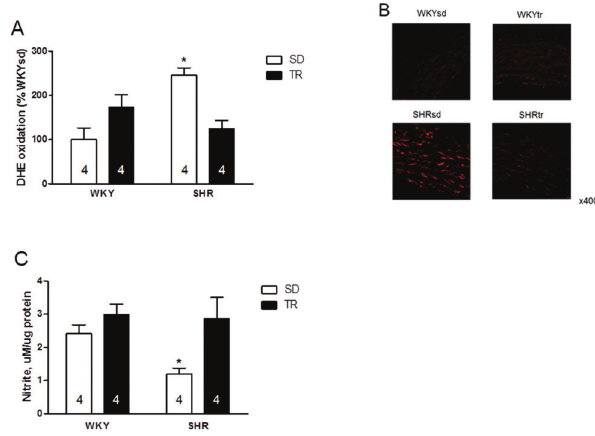
Figure 5 - Quantitative analysis of the superoxide content, * p =0.01 SHRsd group compared with the SHRtr, WKYtr and WKYsd groups (A); representative fluorescence micrographs of confocal microscopy images (B) and vascular nitrite levels * p =0.002 SHRsd compared with the SHRtr, WKYsd and WKYtr groups (C) in samples of the aortas from the WKYsd, WKYtr, SHRsd and SHRtr groups. The data are presented as the mean ±